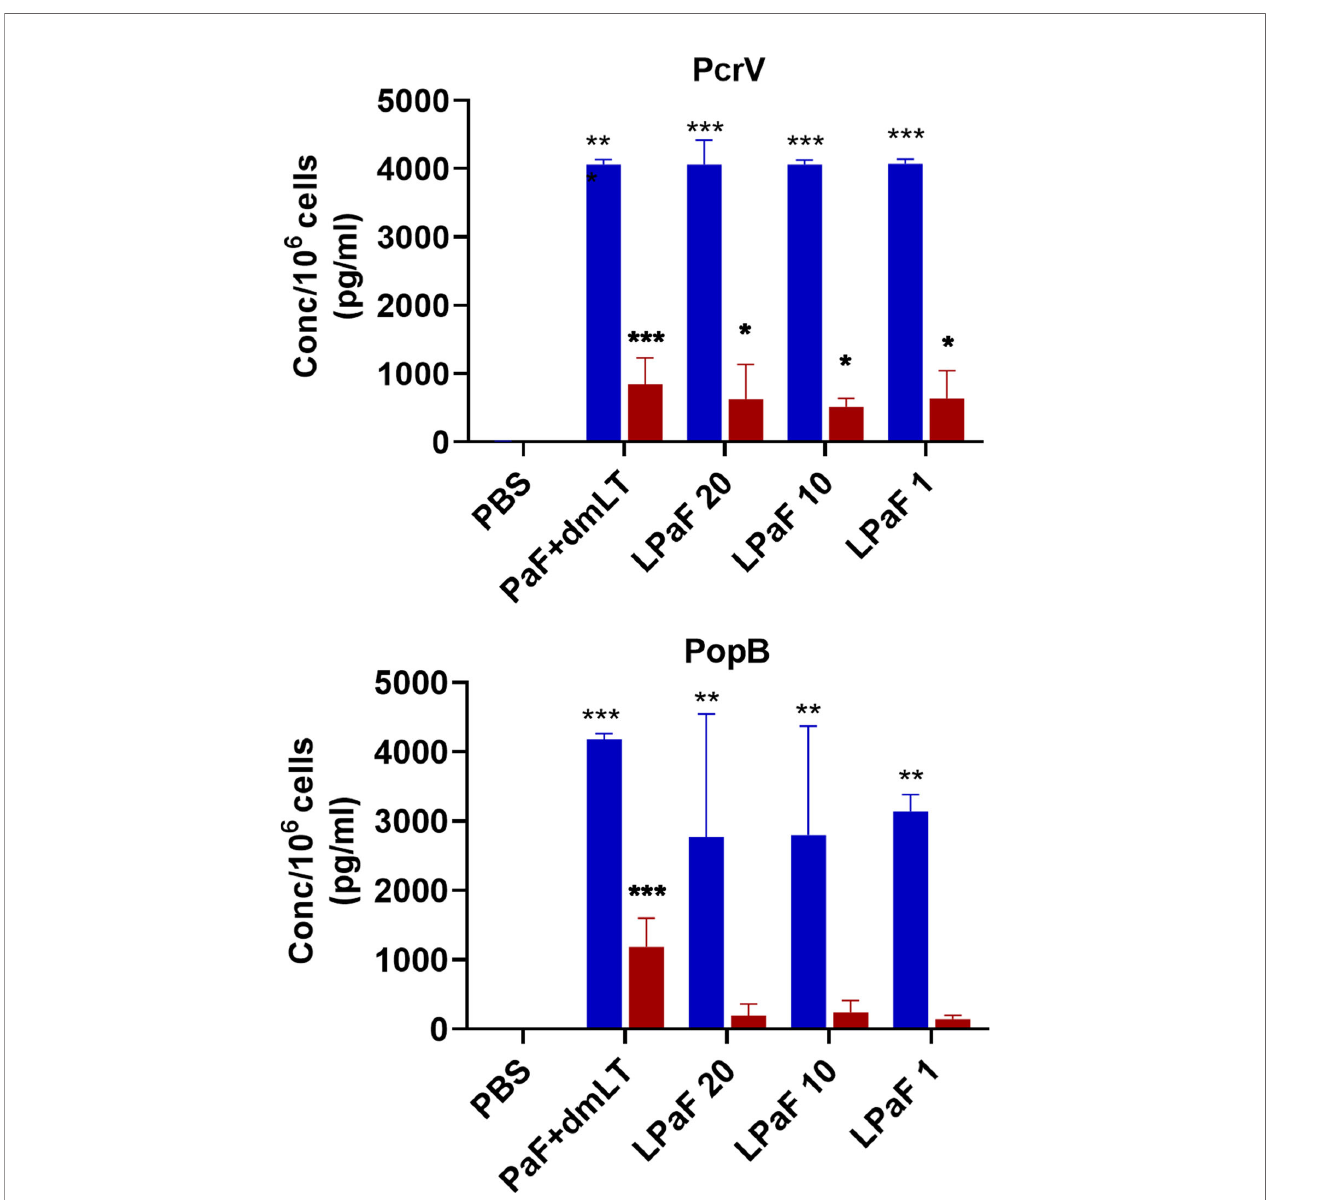
FIGURE 8 | Levels of IL-17 and IFN- g secreted from pre-challenge mice lung cells after stimulation with PcrV or PopB. The single lung cell suspensions from Figure 7 were used to assess antigen speci fi c IL-17 and IFN- g secretion from lung cell suspensions. Cells were incubated with 10 µg PcrV (top) or PopB (bottom). IL-17 (blue bars) and IFN- g (red bars) levels were determined by MesoScale Discovery analysis as per manufacturer ’ s speci fi cations and are presented here as pg/ml/10 6 cells. The data are plotted as means ± SD for individual mice in each group. Signi fi cance was calculated by comparing groups that were unvaccinated (PBS) and mice vaccinated with antigens using two-way ANOVA. *p < 0.05; **p < 0.01; ***p <